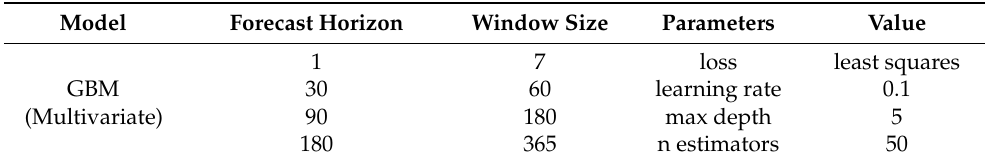
Table 3. Summary of model parameters for the GBM model. Model Forecast Horizon Window